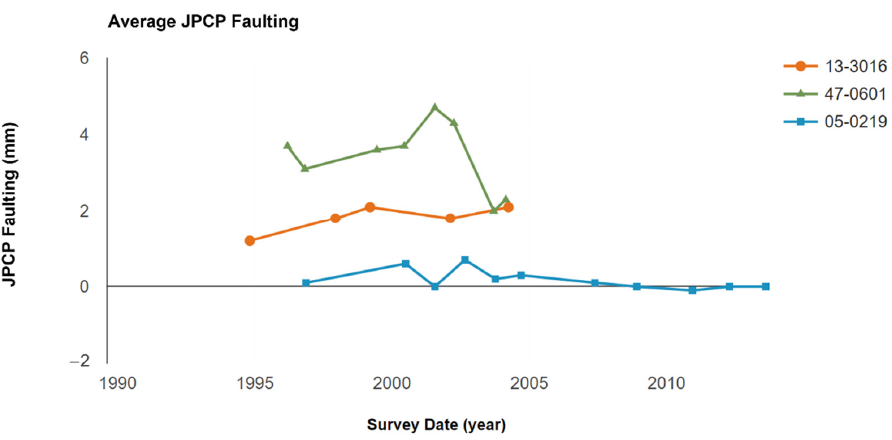
Figure 6. The comparison of the average JPCP faulting with different joint